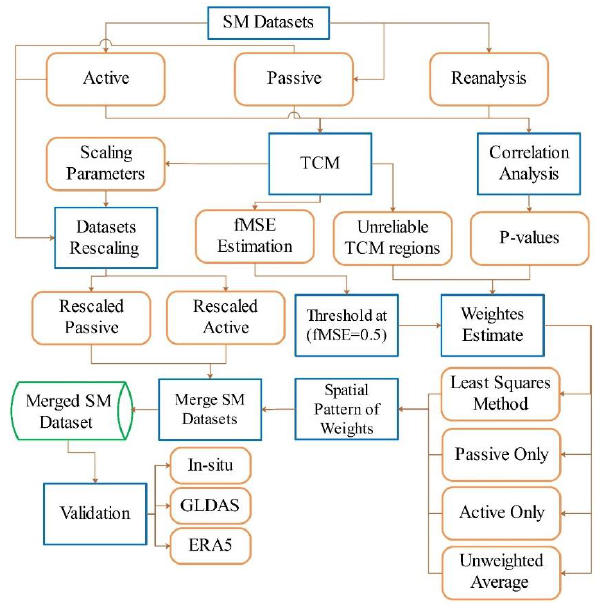
Figure 3. Flowchart of the proposed methodology for merging SM datasets.